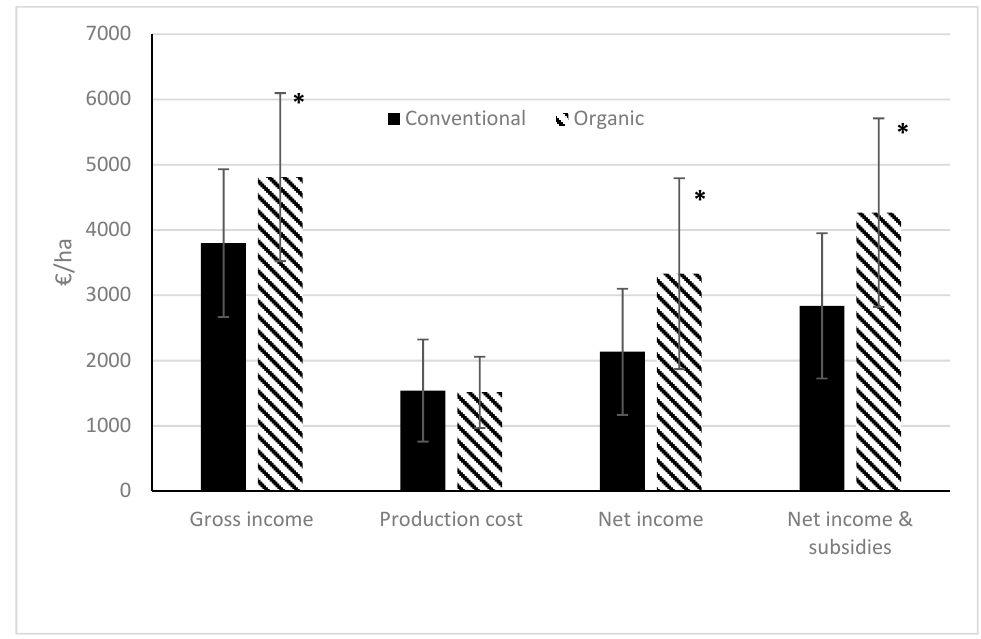
Figure 8. Annual income, costs and profits from olive oil production among organic ( n = 16) and conventional ( n = 23) olive farmers in Messenia, Greece. The error bars indicate the standard deviations. The asterisks (*) mark statistically significant differences (<0.05) between the two groups of farmers.